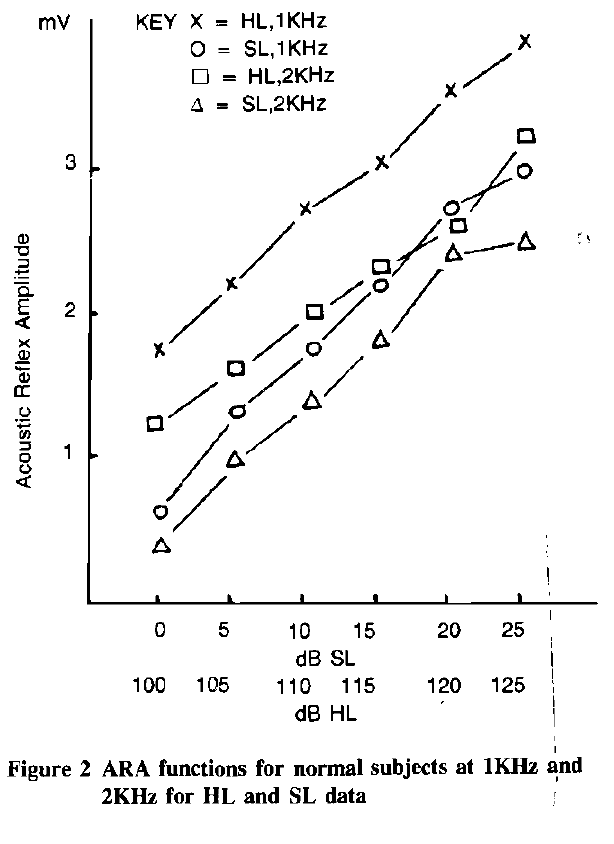
2 KHz for HL and SL data